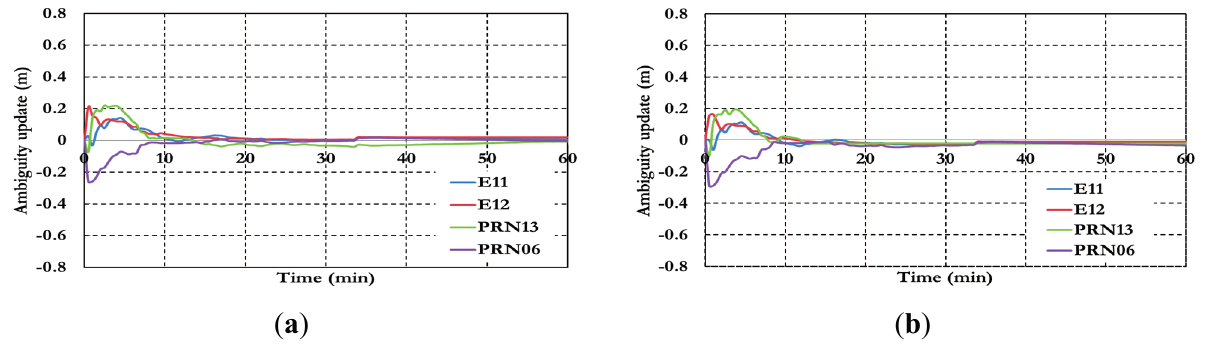
Figure 21. Ambiguity parameters the semi-decoupled GPS/Galileo PPP model ( a ) GPS reference satellite; and ( b ) Galileo reference satellite.